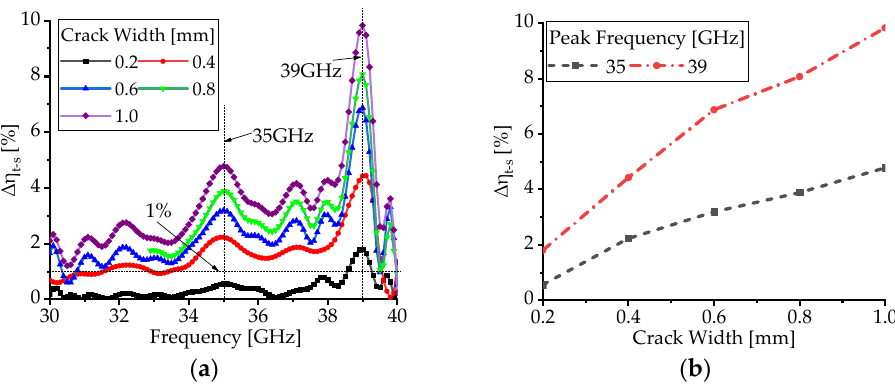
Figure 6. Simulation results of cracks of different widths in 30–40 GHz bands. ( a ) Corresponding to different values of w, the relationship between ∆ η t − s and frequency when d = 1 mm, l = 100 mm, and θ = 0 ◦ . ( b ) The relationship between ∆ η t − s and w at different peak frequencies when d = 1 mm, l = 100 mm, and θ = 0 ◦